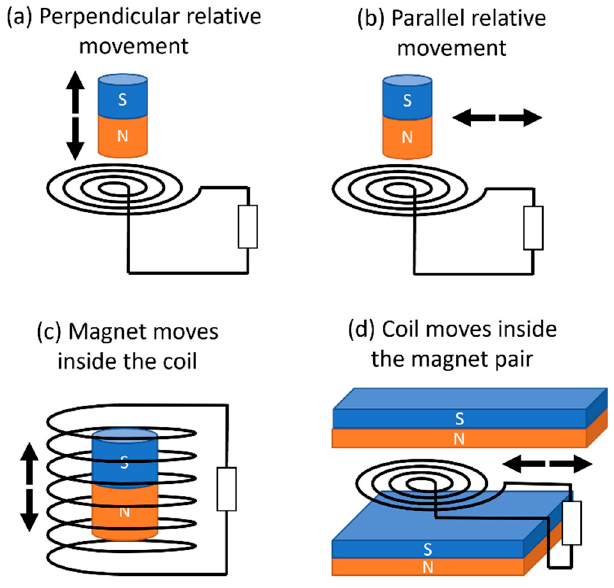
Figure 9. Physical principle of electromagnetic generator: ( a ) perpendicular relative movement, ( b ) lateral or parallel relative movement, ( c ) magnet movement inside the coil, ( d ) coil relative movement in-between magnets [9].